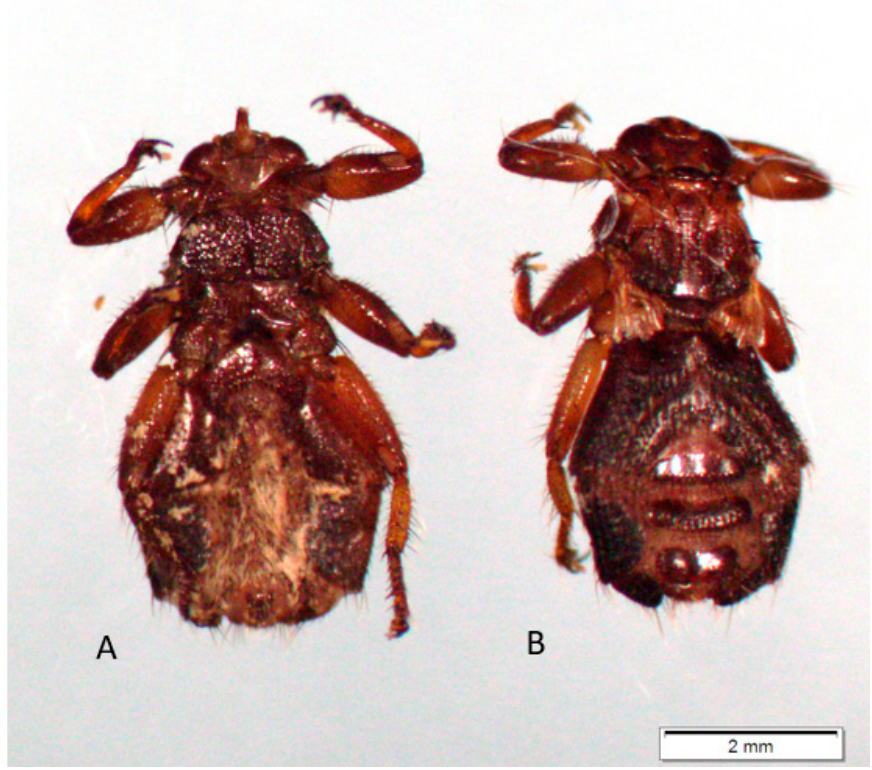
Figure 4. Female Lipoptena cervi . Ventral side ( A ) and dorsal side ( B ).